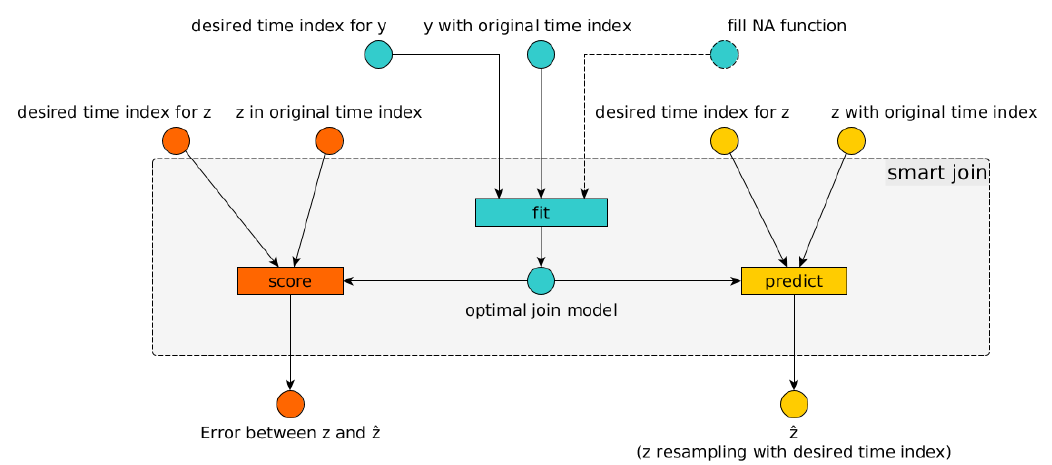
Figure 1. Smart join methodology implementation structure. Firstly fit method is used for the selection of the optimal join method and then, predict and score methods are used to resample other slices of the time series and in order to control the error produced by the